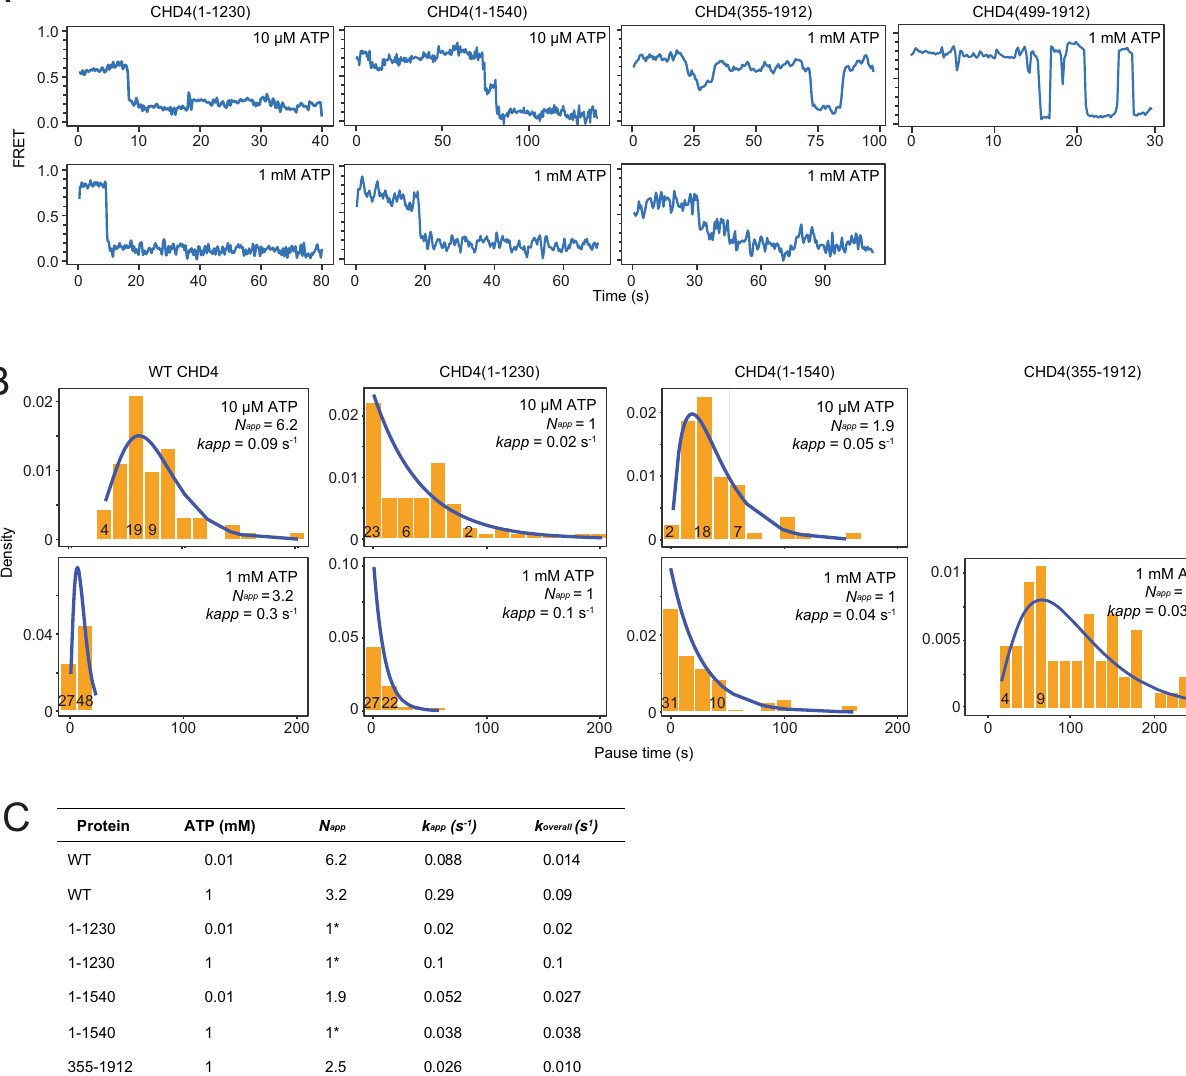
from fi ts of the data in B . k app is the pseudo fi rst-order rate constant for a single RDS.